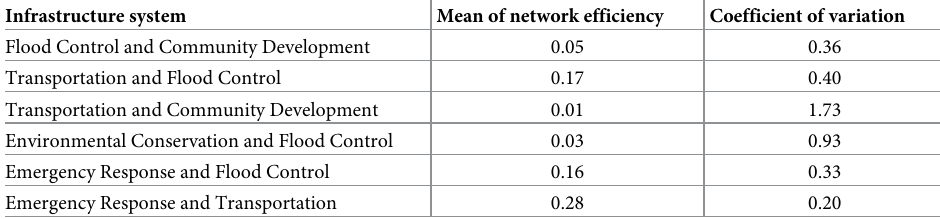
Table 6. Network efficiency under inter-layer link perturbation.